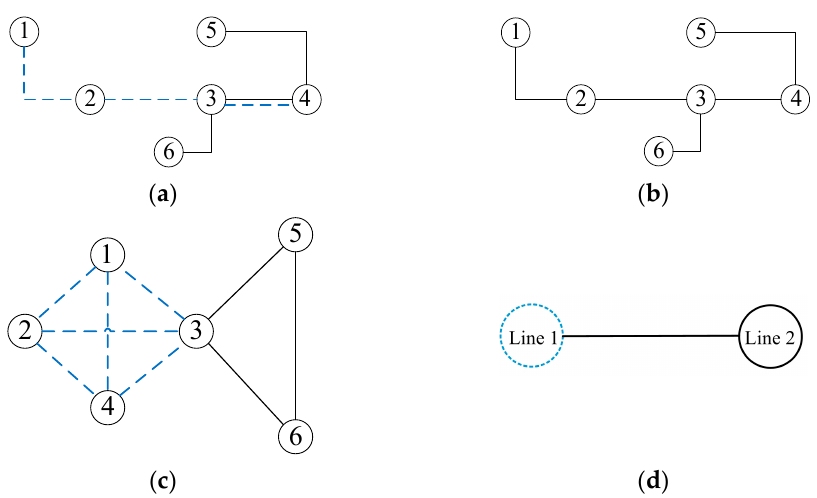
Figure 1. Representations of some subway networks. ( a ) Original network. ( b ) Space L network. ( c ) Space P network. ( d ) Space C network.